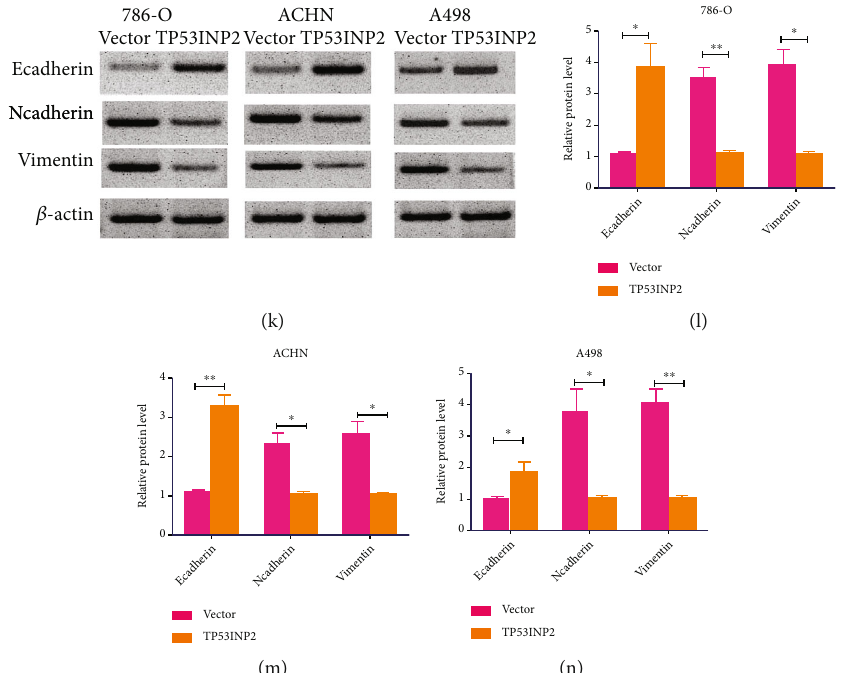
Figure 7: Overexpression of TP53INP2 led to inhibitions on the cellular migration and the cellular invasion of ccRCC cell lines. Both wound healing experiment (a) – (f) and transwell assays (g) – (j) were for the veri fi cation on the e ffi cacy of TP53INP2 overexpression on migrative and invasive capabilities of 786-O, ACHN, and A498 cell. (k) – (n) Levels of epithelial marker E-cadherin and mesenchymal marker (Ncadherin and vimentin) in TP53INP2-overexpressed cells were measured with western blot. Data were presented as mean ± SD of three or four independent experiments. ∗ P < 0 : 05 ; ∗∗ P < 0 : 01 ; ∗∗∗ P < 0 : 001